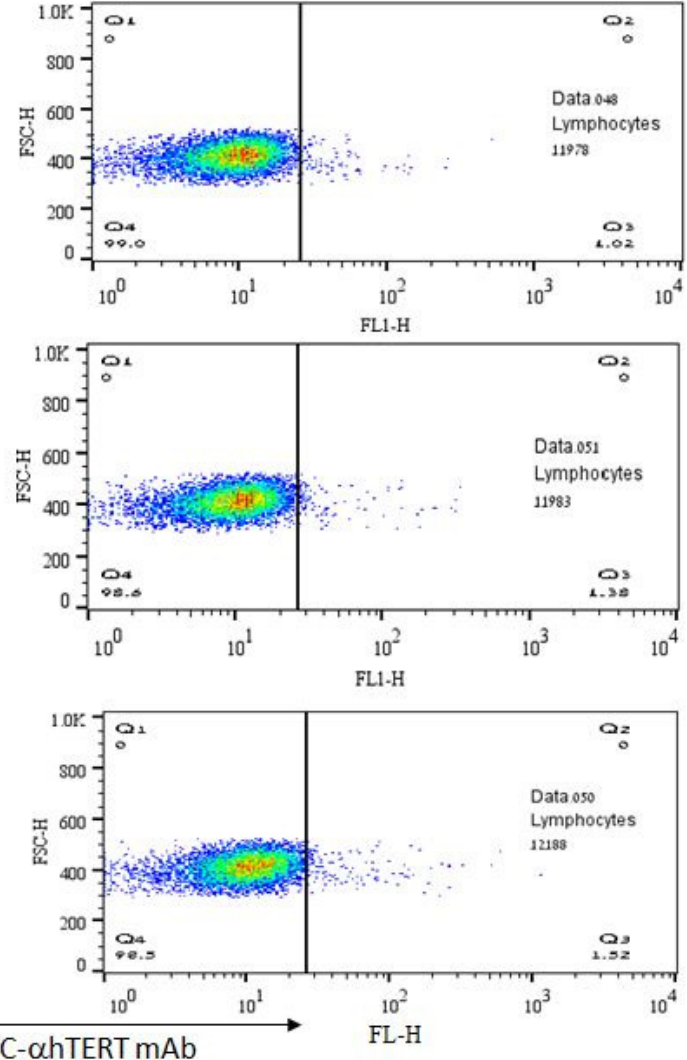
Figure 5. No binding of the α -hTERT mAb to lymphocytes of healthy volunteers. The α -hTERT mAb was added to PBMCs of healthy donors, stained with FITC- α -mouse secondary antibody as described in the Materials & Methods and analyzed by flow cytometry.